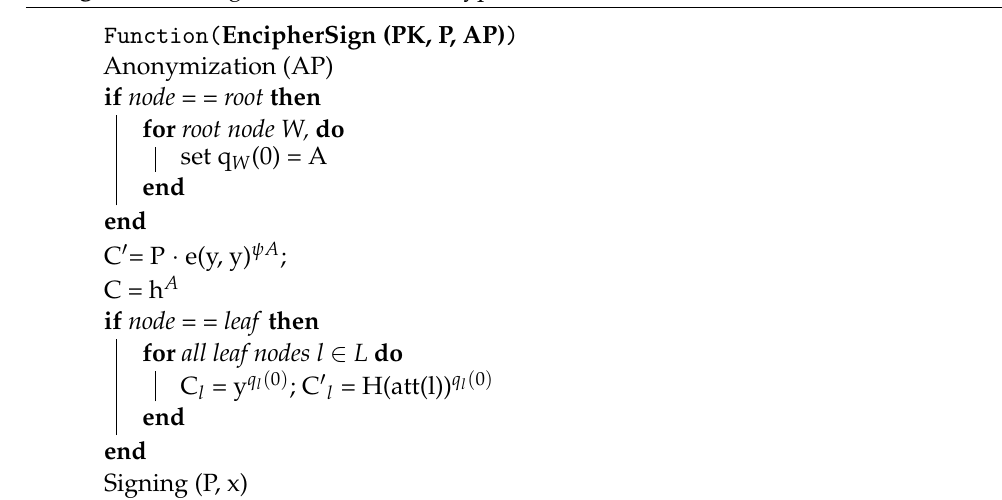
Algorithm 2: Algorithm for data encryption